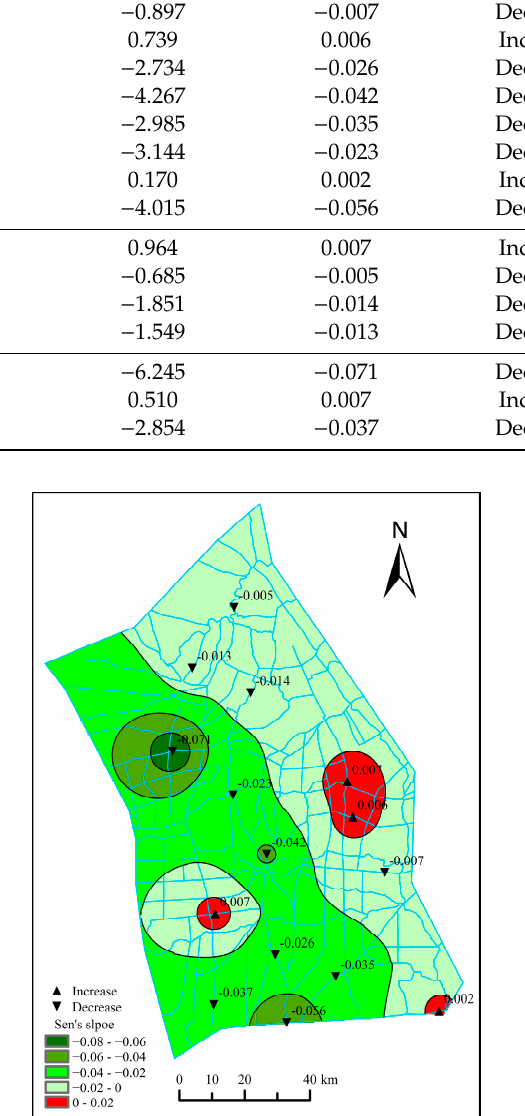
Figure 4. Spatial variation of trend slope of the CWQI.